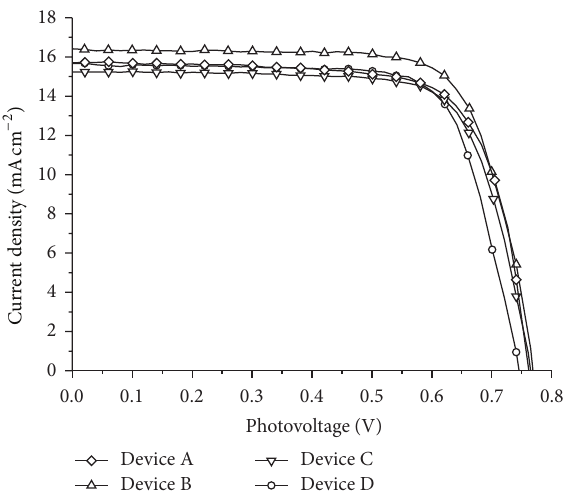
Figure 3: Photocurrent density-voltage characteristics of solar cells sensitized by N719 (Device A), N719: 4L (1:0.25) (Device B), N719 :4L (1: 0.5) (Device C), and N719:4L (1:1) (Device D) with 12.0 + 4.0 𝜇 m double layers nanocrystalline TiO 2 electrodes.